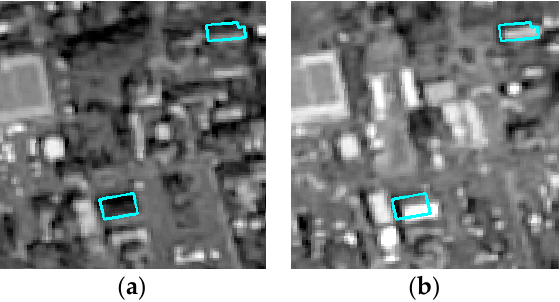
Figure 20. Examples of the estimation of a FP due to bright reflection from building walls drawn in blue outline on a: ( a ) 20 Mar 2016 SPOT image; and ( b ) 25 March 2018 SPOT image. In satellite remote sensing, when the satellite image observed with a large incident angle is orthorectified using DTM without the building height model, the geometric position of the roof and wall of the buildings is not able to be corrected. We know that the image appearance of a building